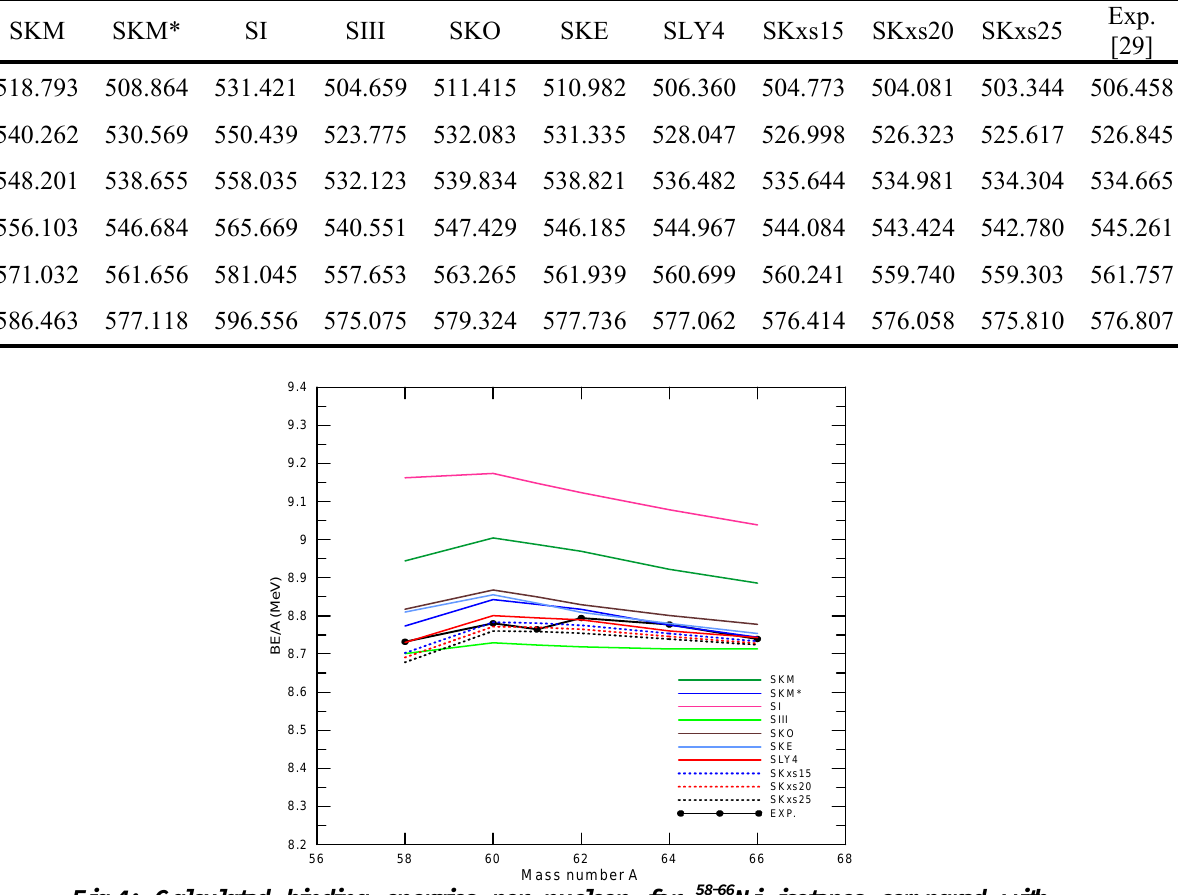
Table 6: The total binding energies (MeV) for the selected Ni-isotopes.